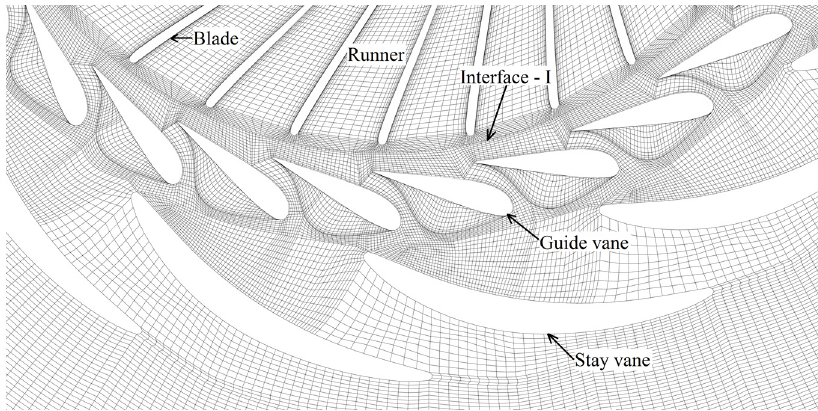
Figure 3. Hexahedral mesh for the distributor and runner of the Francis turbine.